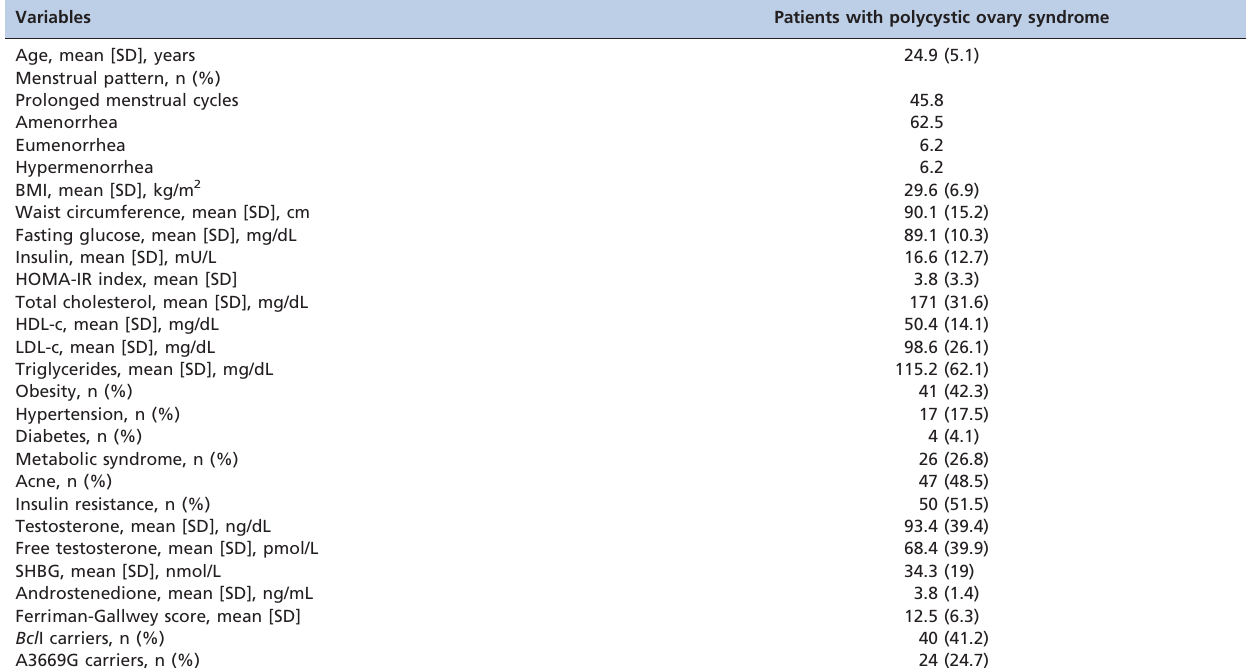
Table 1 - Clinical, laboratory and anthropometric characteristics of the 97 patients with polycystic ovary syndrome.